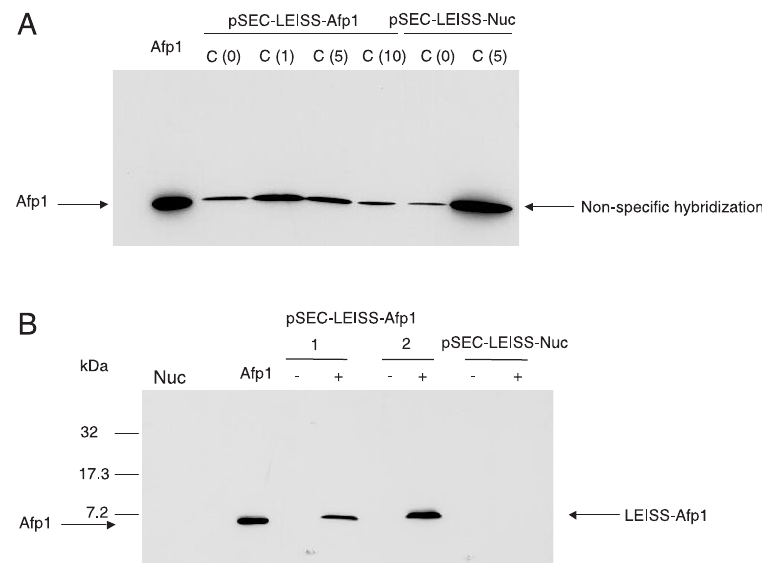
Figure 2. Secretion analysis of Streptomyces tendae antifungal protein 1 (Afp1) in Lactococcus lactis . Afp1 secretion was estimated in exponential phase cultures of recombi- nant lactococcal strains NZ(pSEC-LEISS-Afp1). The NZ(pSEC-LEISS-Nuc) strain was used as a negative control. Protein samples were prepared from cell and supernatant fractions of non-induced (-) and induced (+) cultures. Induction was performed with 10 ng/ mL nisin over a period of 1 h. A, Cell fractions of NZ(pSEC-LEISS-Afp1) and NZ(pSEC- LEISS-Nuc) cultures induced with increasing amounts of nisin; C (0), cell fraction of non- induced cultures; C (1), C (5), and C (10), cell fractions of cultures induced with 1, 5 and 10 ng/mL nisin, respectively. B , Supernatant fractions of NZ(pSEC-LEISS-Afp1) and NZ(pSEC- LEISS-Nuc) cultures not induced (-) or induced (+) with 10 ng/mL (1 and 2 correspond to two independent experiments). Position and size of molecular weight markers are indicated on the left